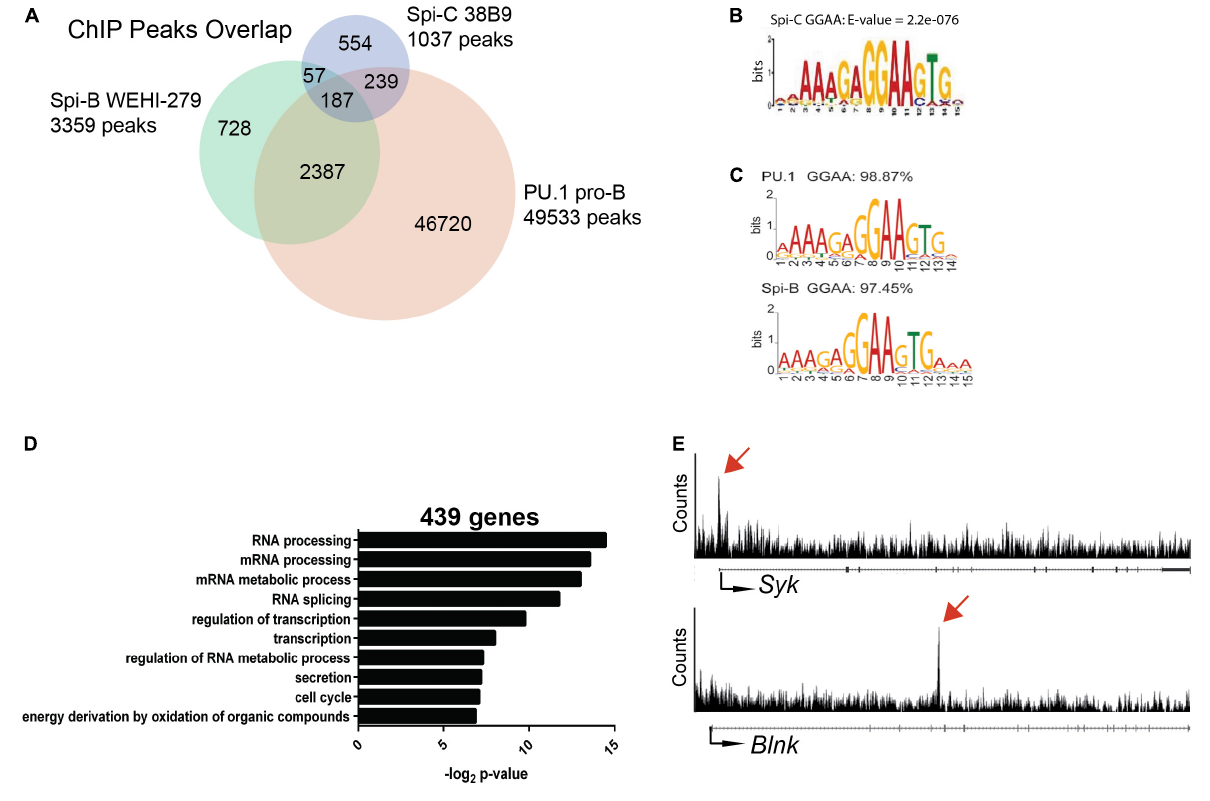
FIGURE 5 | ChIP-seq analysis of Spi-C interaction in 38B9 cells. (A) Venn diagram showing overlap in binding sites. Genomic regions from ChIP analysis (peaks) were compared for Spi-C in 38B9 cells (blue), PU.1 in pro-B cells (red) and Spi-B in WEHI-279 B lymphoma cells (green). Numbers indicate the number of unique or overlapping peaks. (B) DNA interaction motifs recovered from Spi-C ChIP-seq analysis. (C) DNA interaction motifs recovered from PU.1 (top) and Spi-B (bottom) ChIP-seq analysis. (D) Biological pathways were identified from 439 genes interacting with Spi-C using DAVID analysis. (E) Representative Spi-C peaks in 38B9 cells for genes encoding Syk (top panel) and B cell linker protein ( Blnk , lower panel). Red arrows indicate location of Spi-C